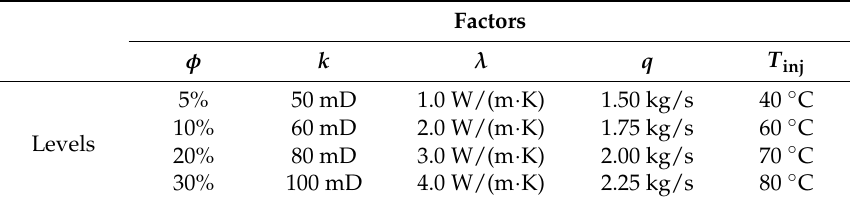
Table 1. Orthogonal problem with five influential geological factors and their levels. Reservoir porosity ( φ ); reservoir permeability ( k ); rock heat conductivity ( λ ); water production rate ( q ); injection temperature ( T inj ).